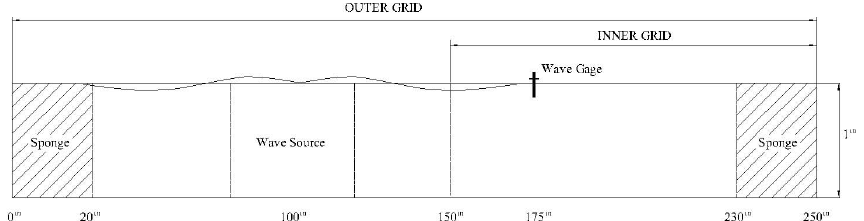
Fig. 4. Sketch of the water flume and computational grids. The plot is not on scale.